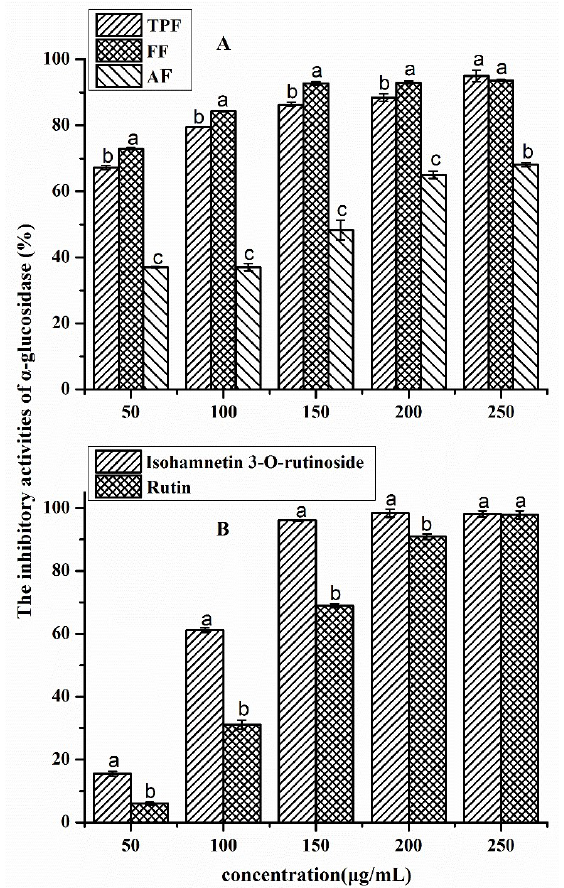
Figure 5. Inhibitory ratio of α -glucosidase activity by different fractions from P. utilis fruits ( A ), and isorhamnetin-3- O -rutinoside and rutin ( B ). Values are shown as the mean ± SD ( n = 3). Means with different letters at the same concentration are significantly different ( p < 0.05).